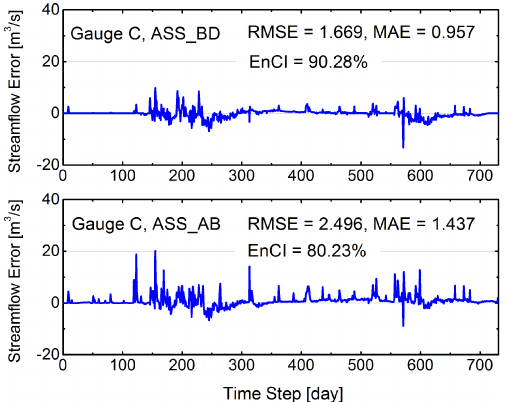
Figure 3. Streamflow prediction errors from scenarios ASS_BD and ASS_AB. Only the results for Gauge C are shown because Gauge C is at the outlet of a pseudo-ungauged subbasin in both